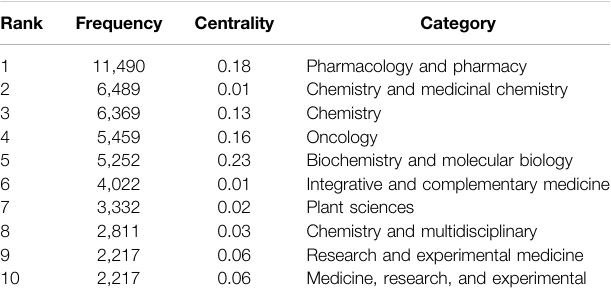
TABLE 5 | List of the subject co-occurrence network for anticancer natural